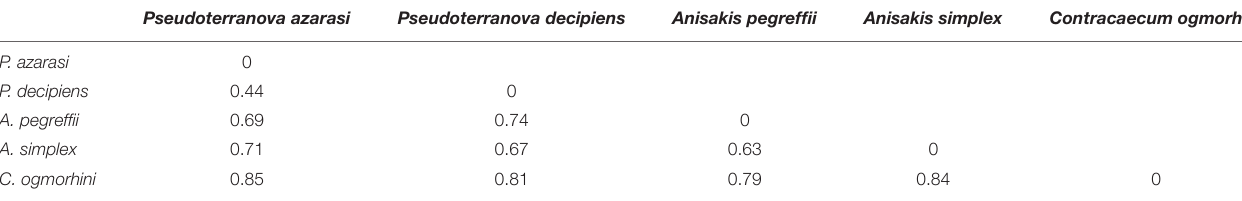
TABLE 3 | Matrix of pairwise F ST values between populations of five species from Anisakidae isolated from California sea lions. Pseudoterranova azarasi Pseudoterranova decipiens Anisakis pegreffii Anisakis simplex Contracaecum